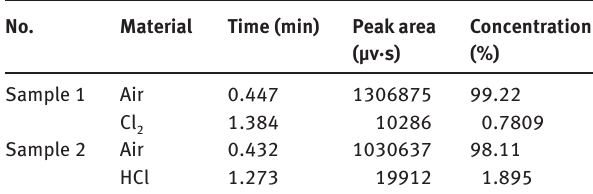
Table 2: The GC chromatograms analysis results of gas samples